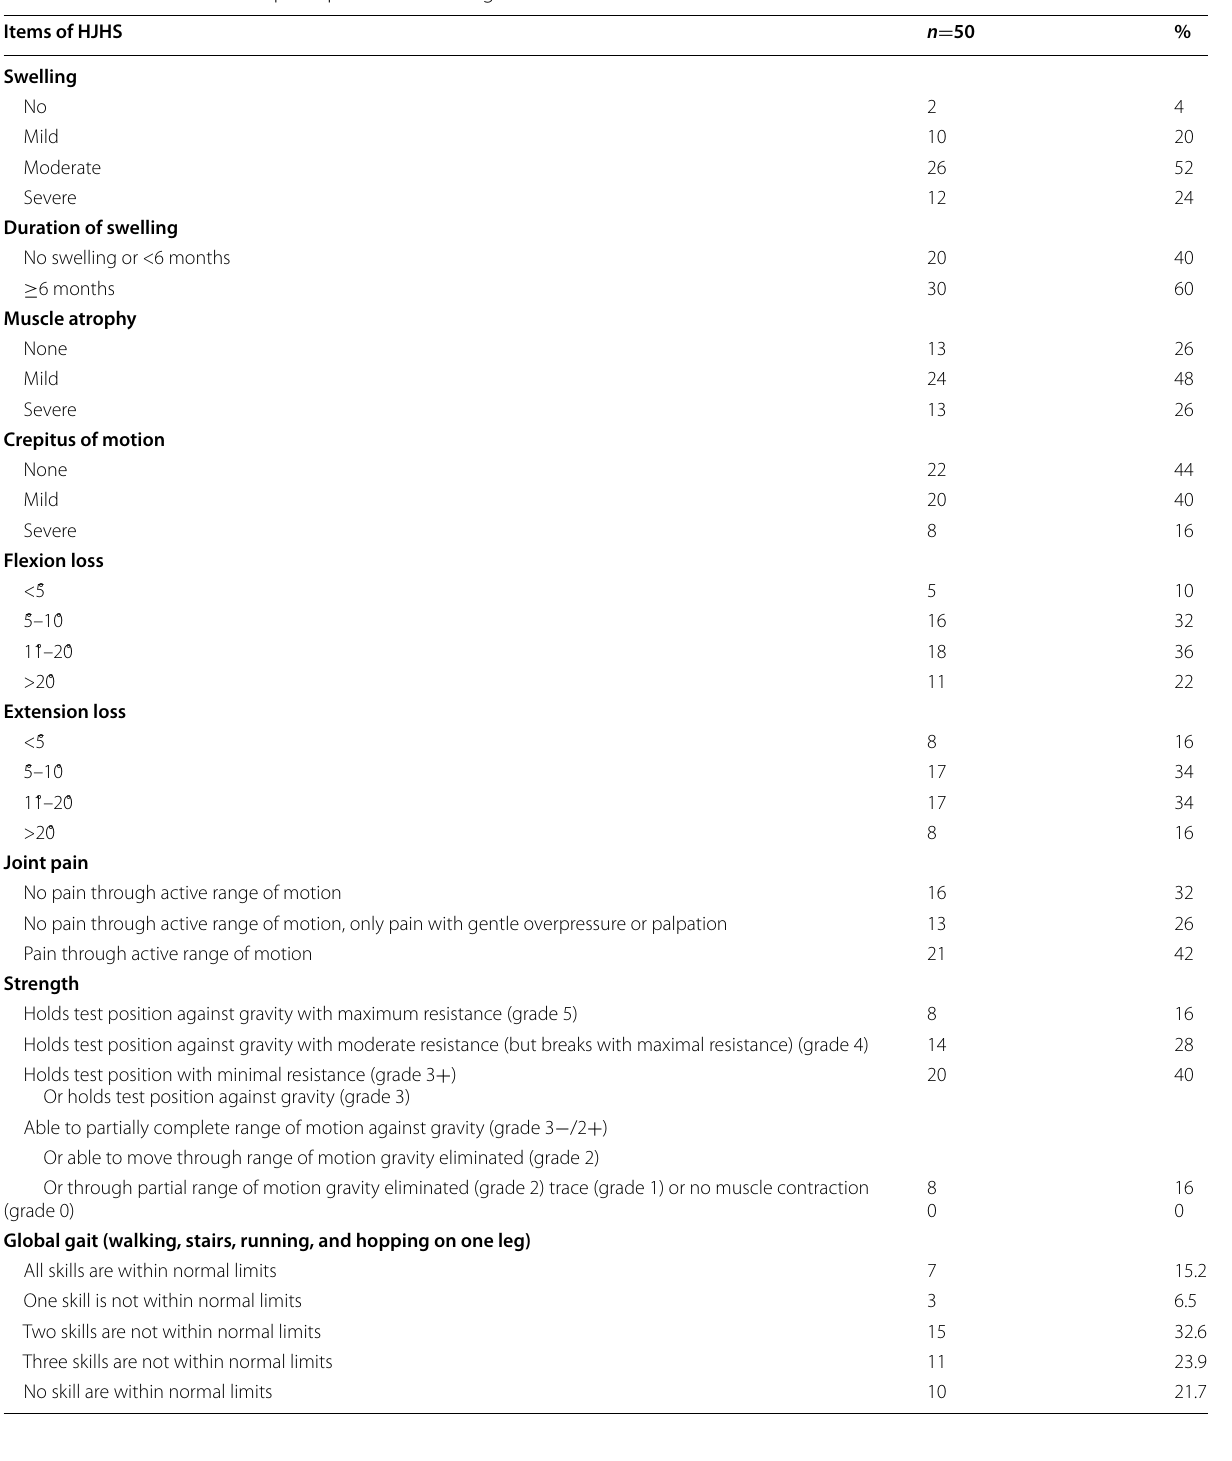
Table 2 Distribution of hemophilic patients according to items of HJHS score Items of